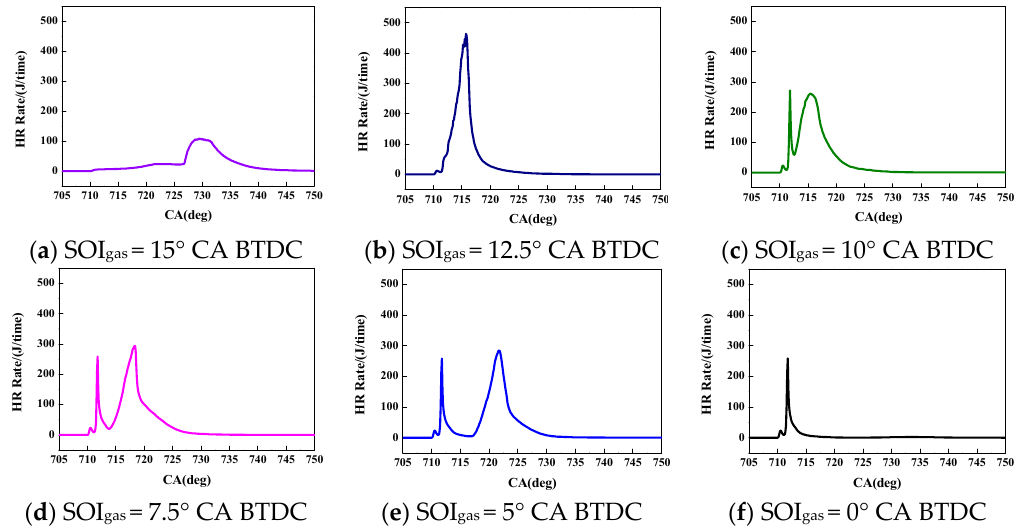
Figure 5. Influence of the NG injection timing on the heat release rate.